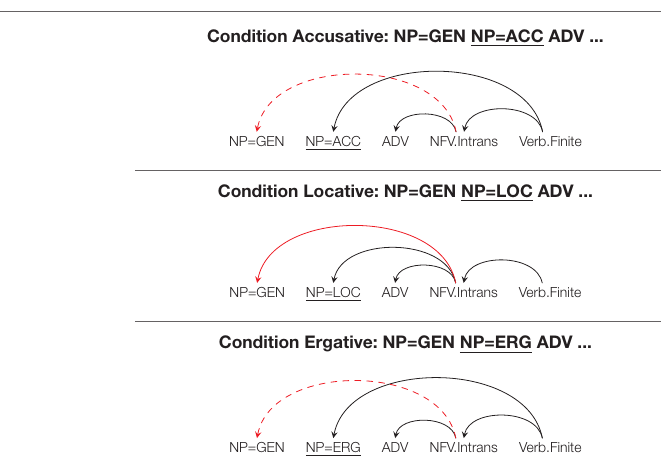
TABLE 3 | Illustration of structures for the target sentence as predicted by the residual activation theory for conditions in Experiment 2. If priming happens, then the critical NP=GEN should be treated as the subject of the NFV.Intrans (shown as a red arc above). In order to use the prime structure in the target for Accusative and Ergative conditions, a crossing dependency (shown as a “dashed” arc above) has to be posited. Prime structure Expected structure in the target assuming successful priming Condition Accusative: NP=GEN NP=ACC ADV